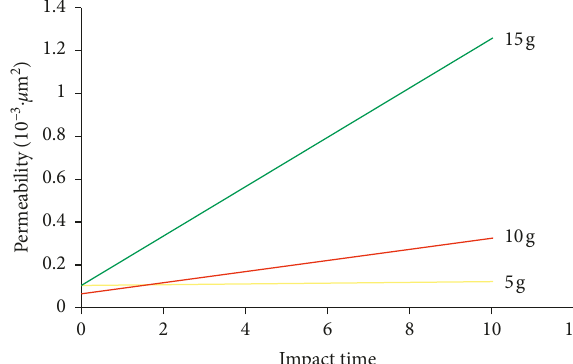
Figure 10: Testing results of porosity and permeability of coal